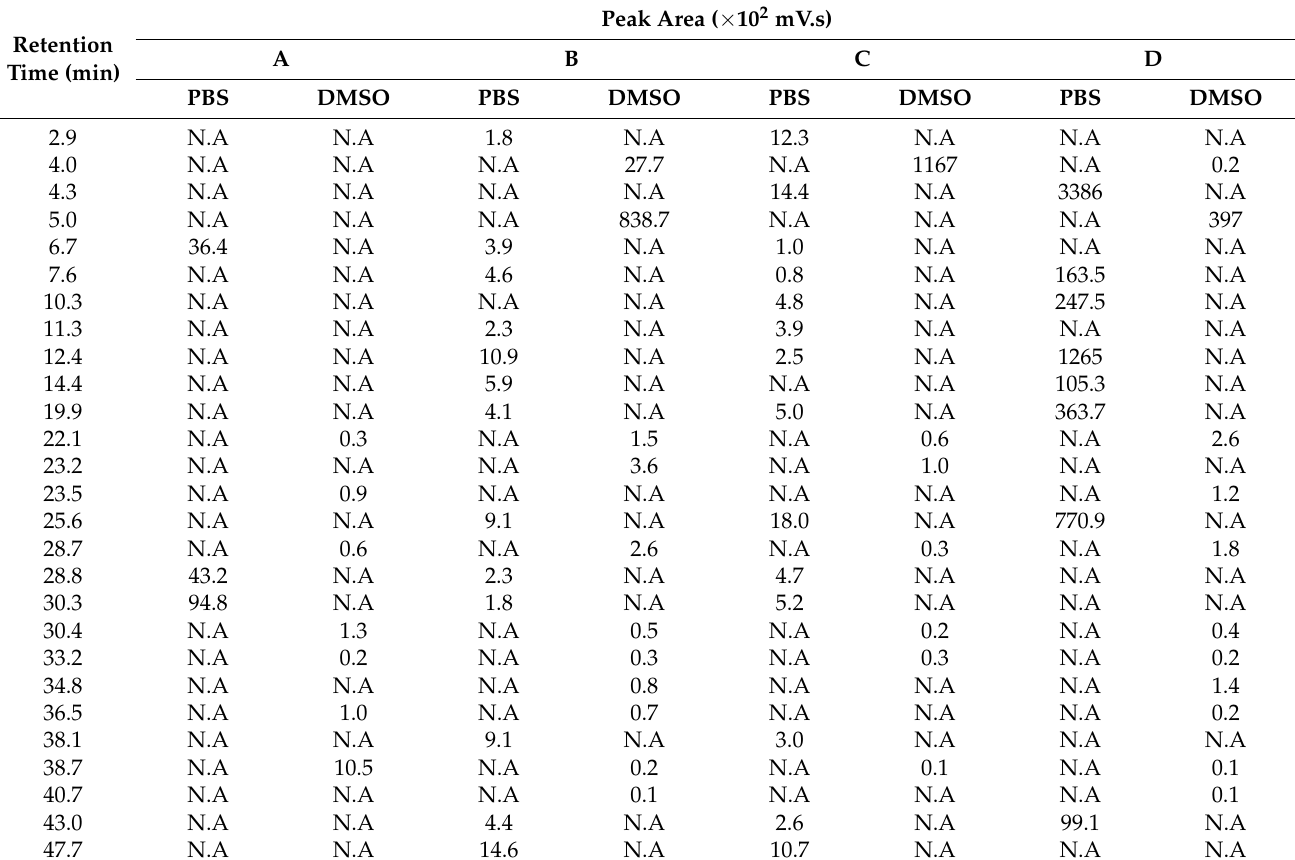
Table 2. RP-HPLC chromatogram peaks profiles of honey bee hemolymph extracts obtained in PBS or